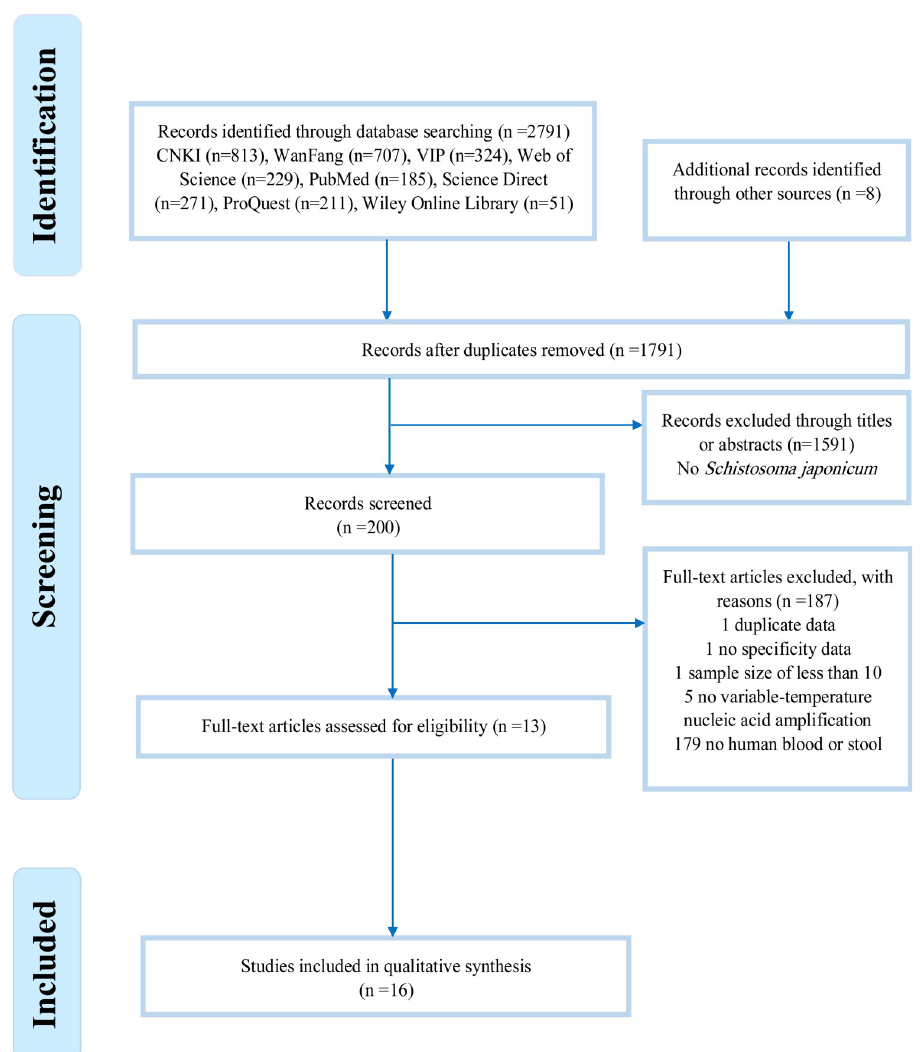
Fig 1. Flow chart of studies on S . japonicum infections detected by PCR tests. The chart shows numbers of titles and studies reviewed in preparation of this meta-analysis. N, the number of studies included in each stage of the process.